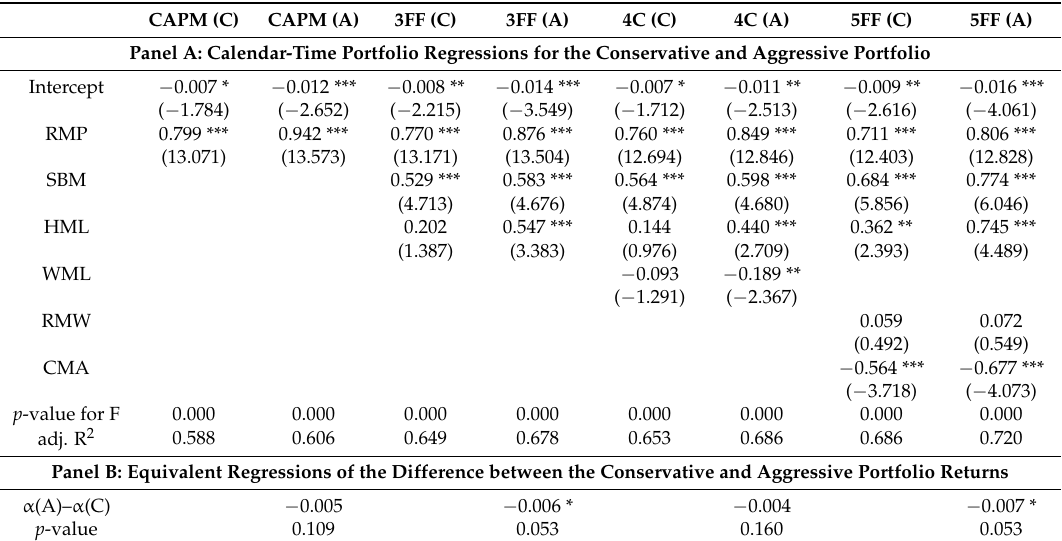
Table 3. Calendar-time portfolio regressions for year in quantiles according to the modified Jones model.